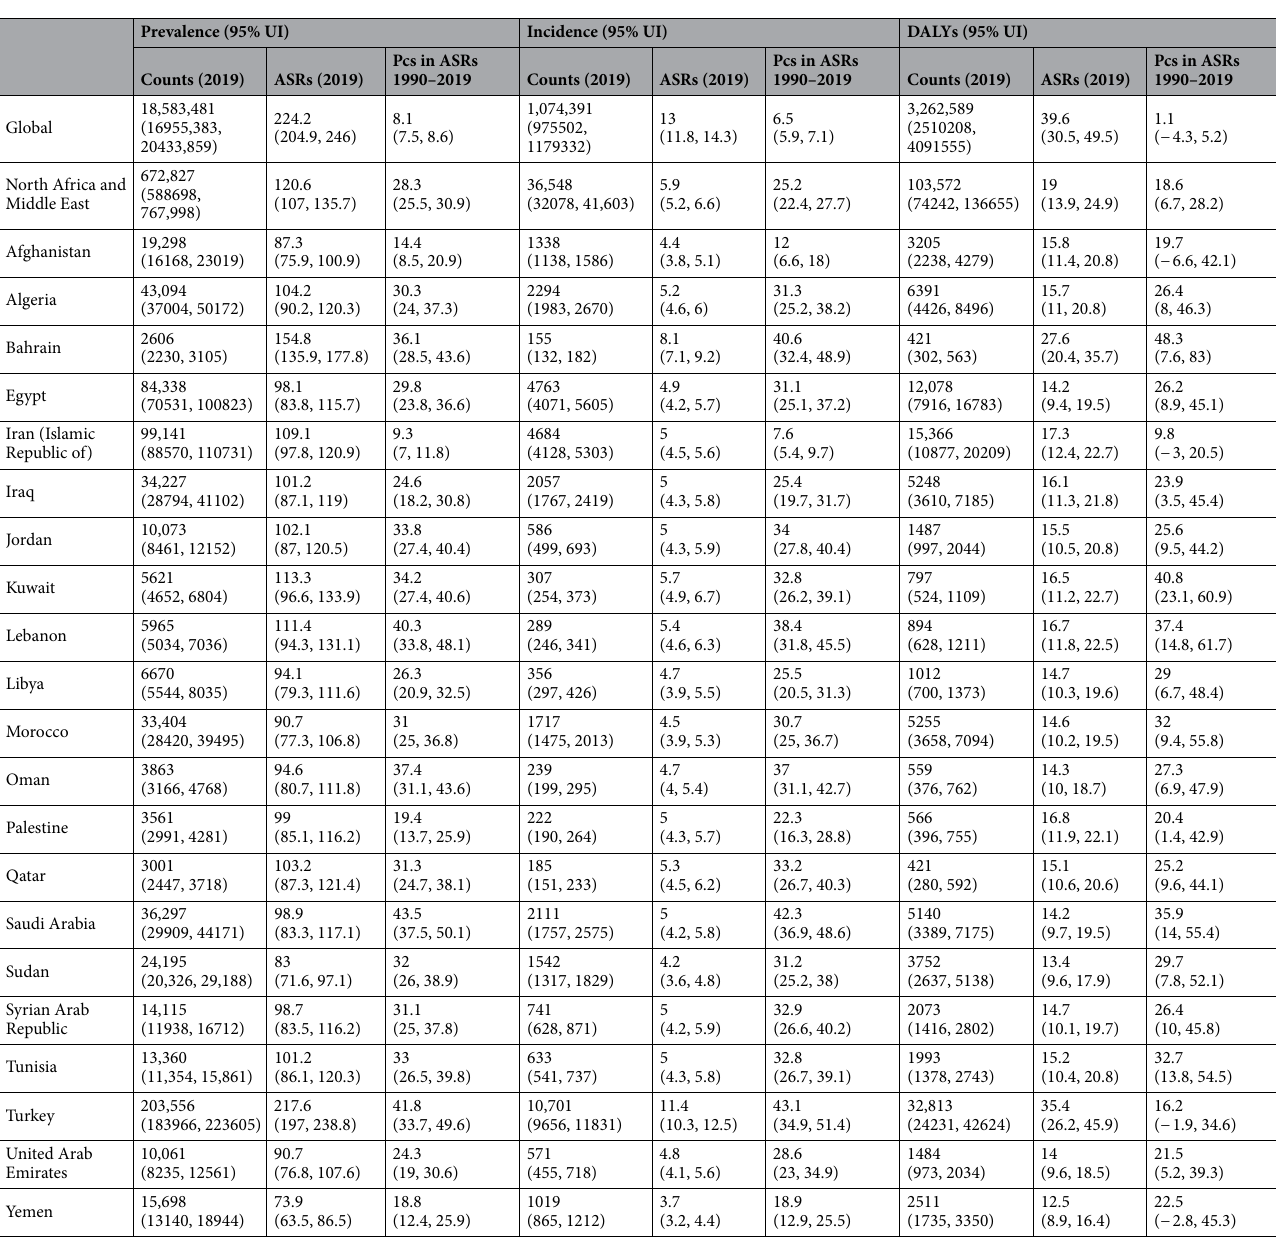
Table 1. Prevalent cases, deaths and DALYs for rheumatoid arthritis for both sexes in 2019 and the percentage change in the age-standardised rates during the period 1990–2019. (Generated from data available from http:// ghdx. healt hdata. org/ gbd- resul ts- tool). DALY Disability-adjusted life-years, UI Uncertainty interval, ASR Age- standardised rate, Pcs Percentage